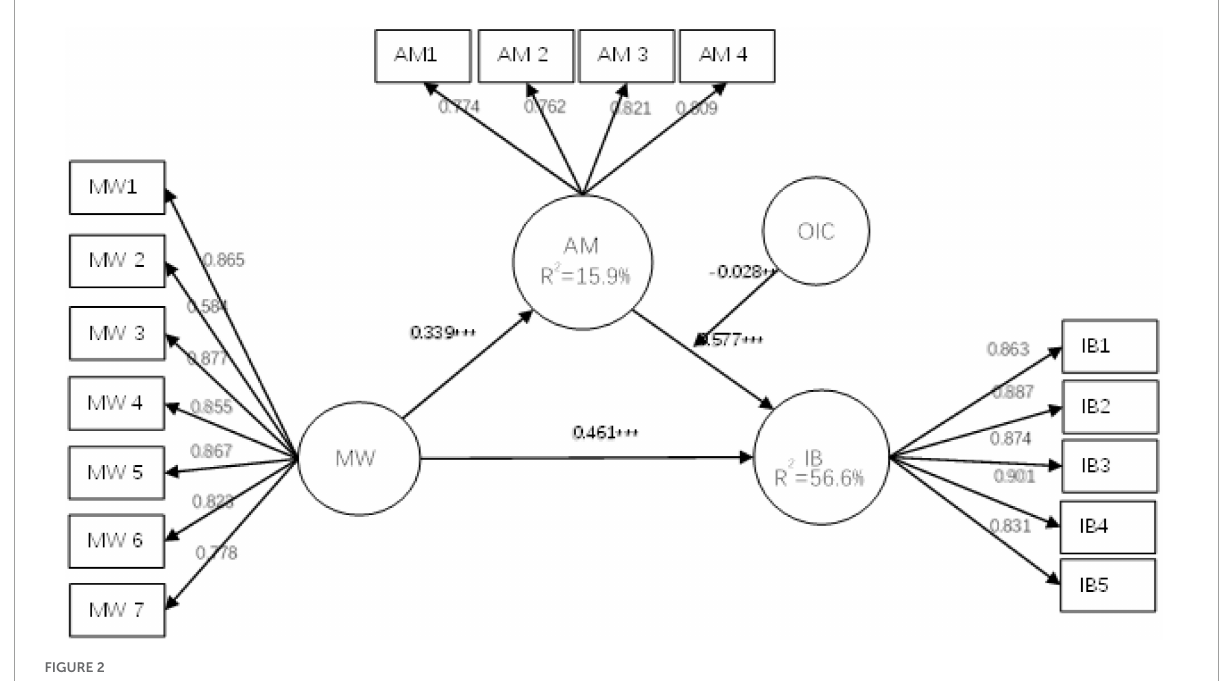
FIGURE2 Final empirical research